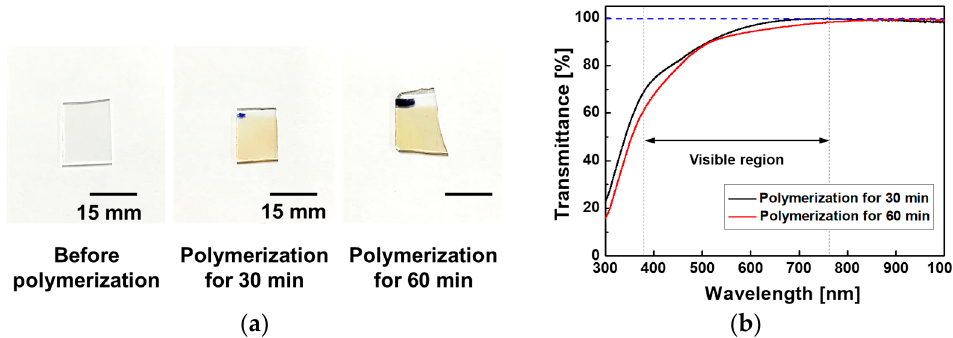
Figure 4. Characterization of transparent polyaniline (PANI) thin films obtained by polymerization on glass substrates for 30 min and 60 min: ( a ) photographic images, and ( b ) the UV-vis optical transmittance spectra.